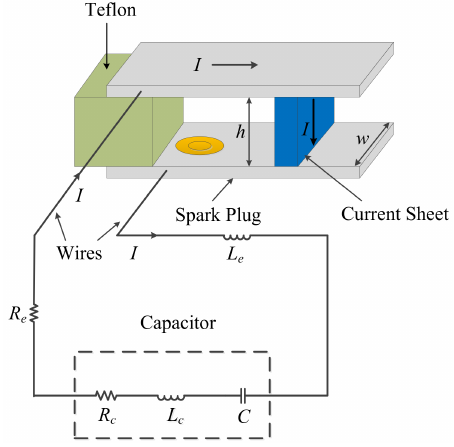
Figure 1. Micro-pulsed plasma thruster ( µ PPT) and